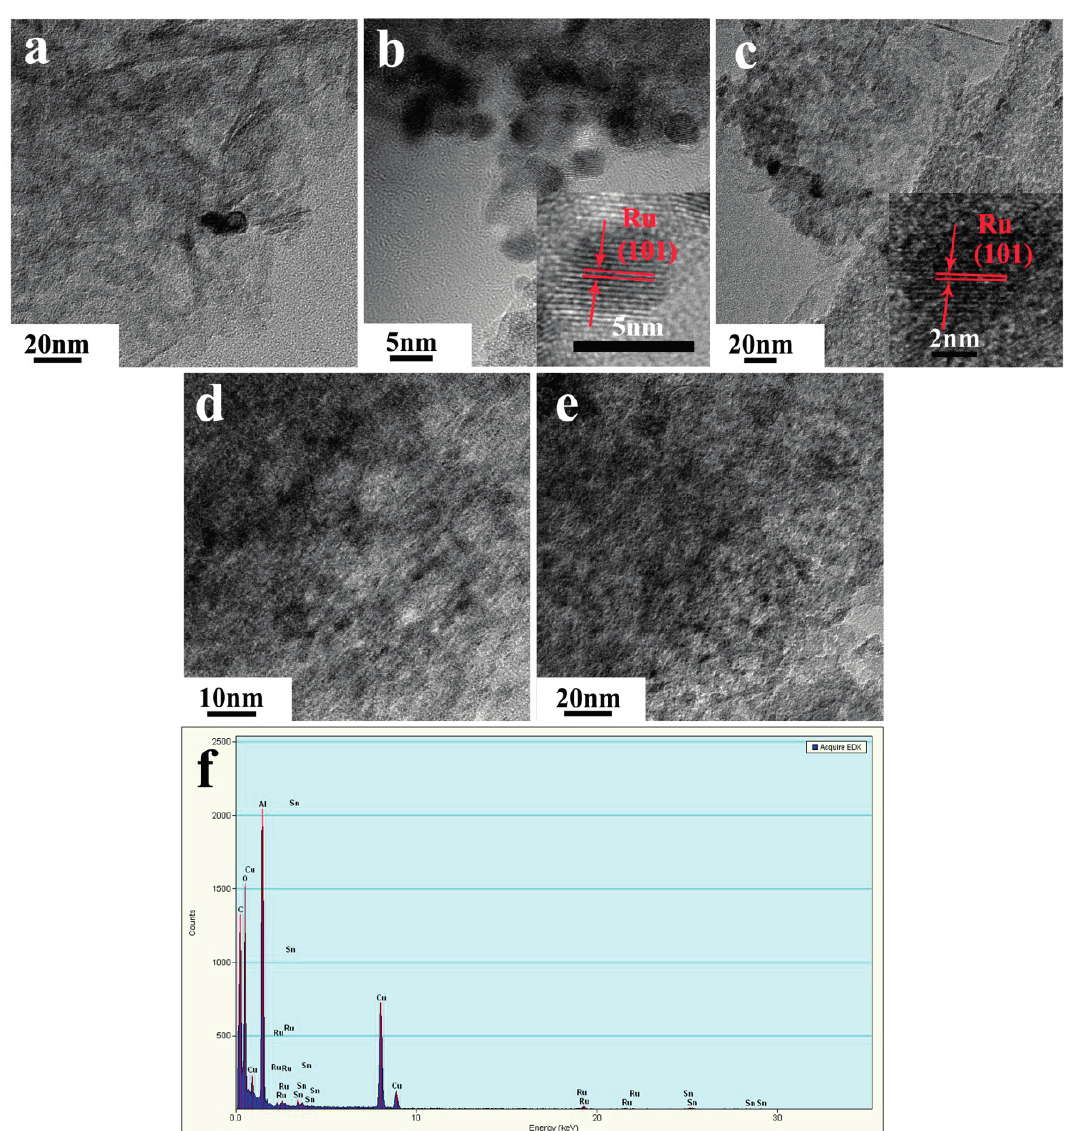
/Al O -3%; and ( e ) the used Ru-SnO x 2 3 /Al O x 2 3